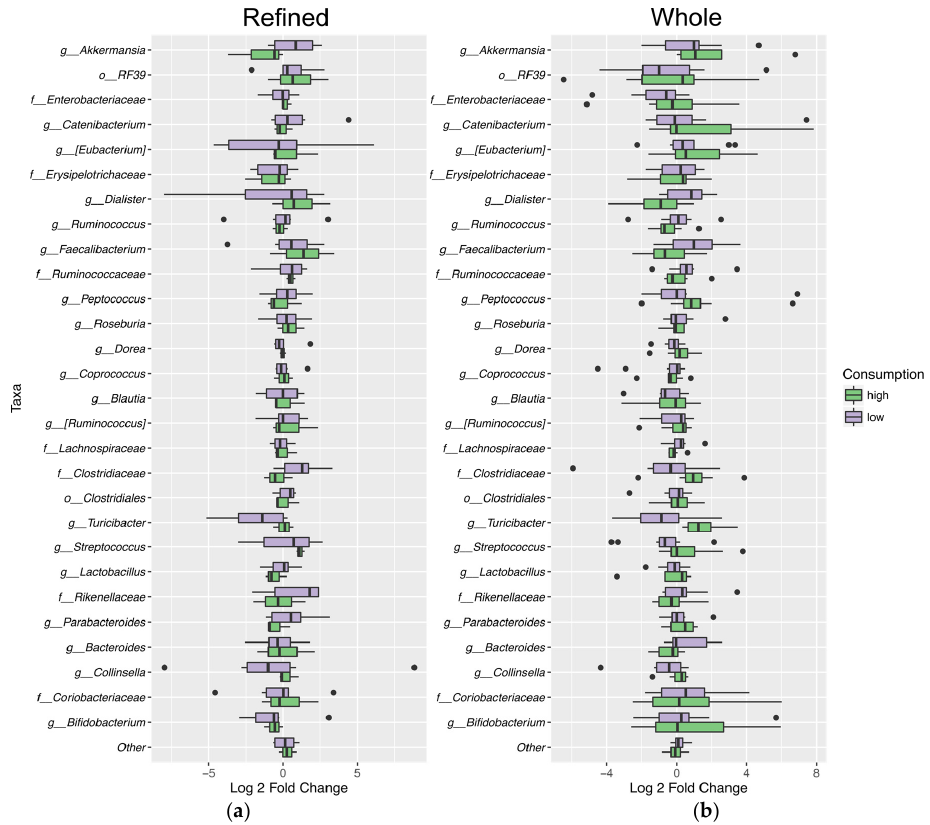
Figure 7. Variation in specific taxa during market basket consumption. Log2 fold change in abundance of bacteria at either high (50% or more) or low (49.99% or less) levels of consumption of the market baskets from baseline to post intervention for: refined grain ( a ); and whole grain ( b ). Taxa shown were present in at least 2% relative abundance in at least one sample. Dots seen in the graphs represent outliers. The findings of interest were an increase in the relative abundance of Akkermansia and Lactobacillus with high whole grain market basket consumption and a decrease with high refined grain consumption, as well as the increased abundance of the order Erysipelotrichales ( p = 0.023) with high refined grain consumption.